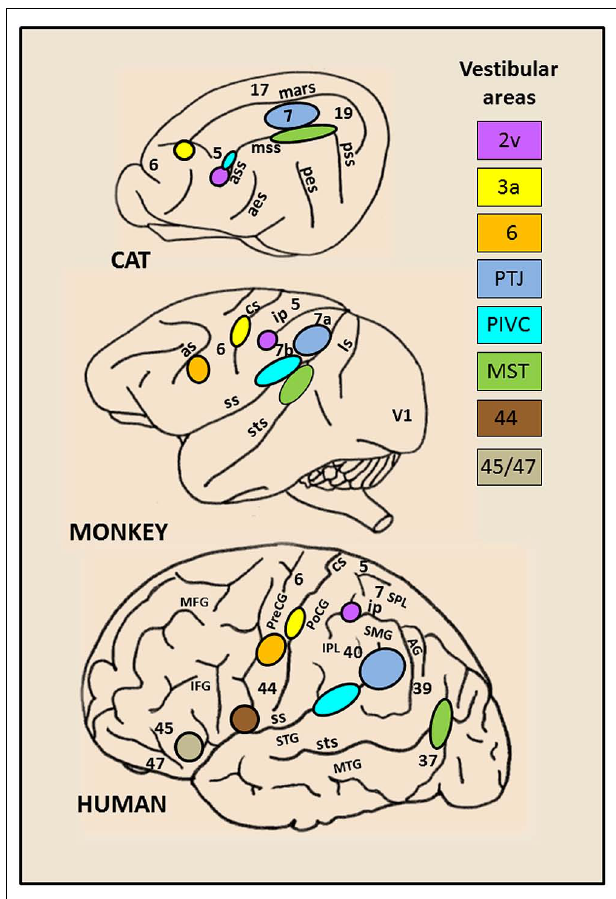
FIGURE 1 | Schematic brain representations illustrating the topography of the vestibular cortical fields as they have been experimentally identified in cat, monkey, and human. The numbers on the cortex indicate the architectonically defined Brodman’s areas (based on (Talairach andTournoux, 1988). In the right panel are listed the vestibular sites with their localization in the cortical regions. In cat: the marginal sulcus (mars), the anterior (ass), middle (mss) and posterior (pss) suprasylvian sulci, the anterior (aes) and posterior (pes) ectosylvian sulci. In primate (monkey and human): the lunate sulcus (ls), the superior temporal sulcus (sts), the sylvian scissure (ss), the intraparietal sulcus (ip), the central sulcus (cs) and the arcuate sulcus (as), the superior (STS) and middle (MTG) temporal gyri, the angular gyrus (AG), the supramarginal gyrus (SMG), the superior (SPL) and inferior (IPL) parietal lobes, the postcentral (PoCG) and precentral (PreCG) gyri, the middle (MFG) and inferior (IFG) frontal